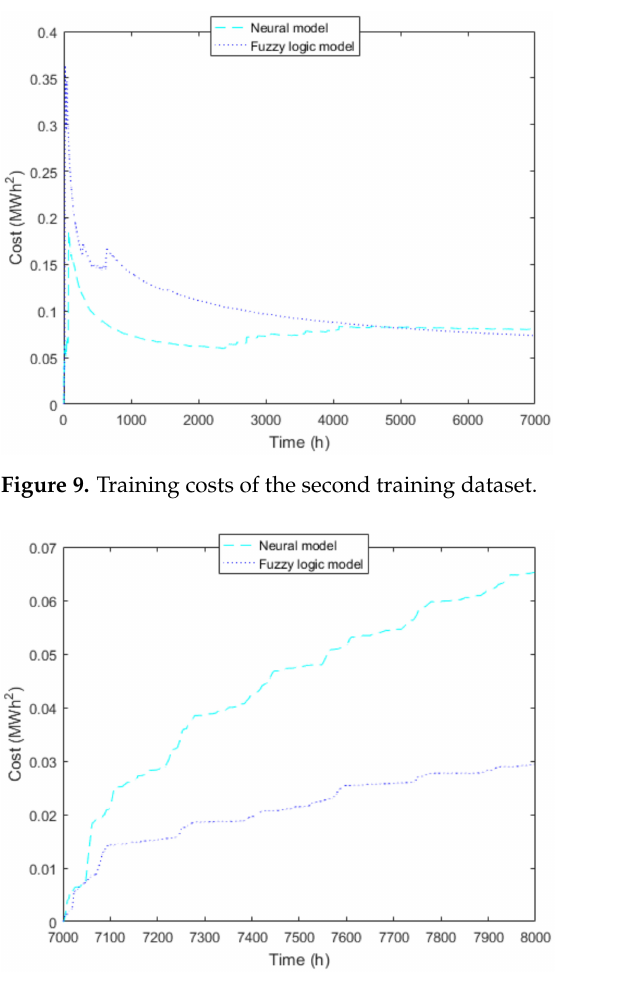
Figure 10. Generalization costs of the second training dataset. Table 3. Costs for the second training